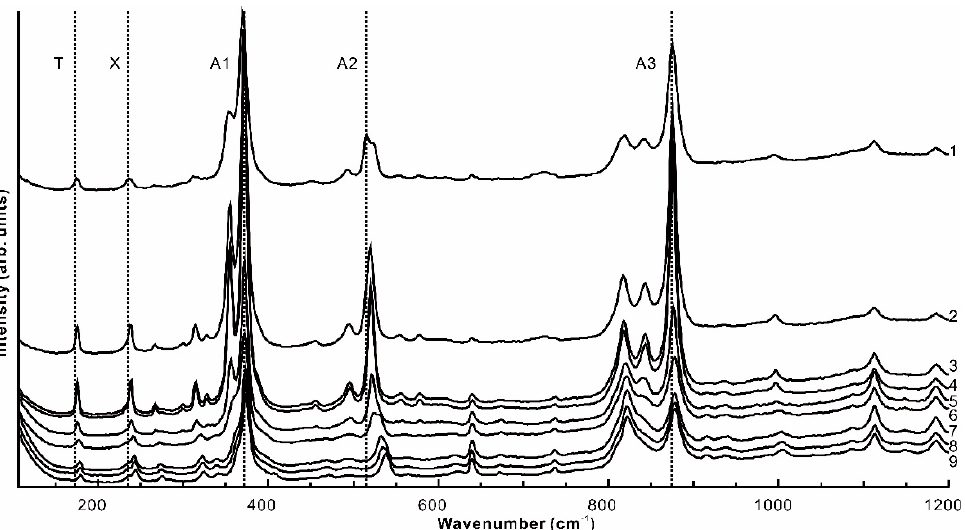
Figure 5. Relationship between the content of andradite and the Raman peaks: ( 1 ) 2412-11 (And94.14Gro0); ( 2 ) 2412-2 (And84.34Gro0); ( 3 ) 2412-12 (And74.70Gro6.15); ( 4 ) 2412-10 (And64.10Gro17.11); ( 5 ) 2412-1 (And56.52Gro25.59); ( 6 ) 2412-8 (And46.57Gro32.73); ( 7 ) 2412-4